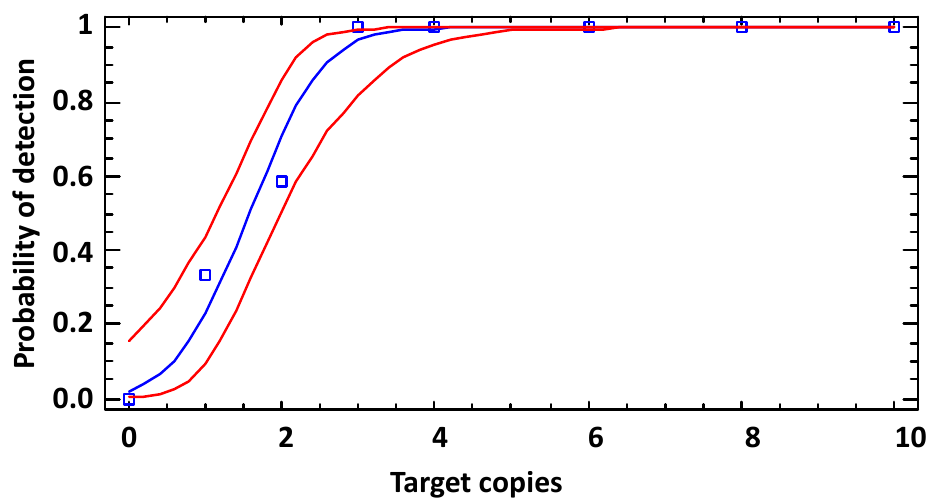
Figure 2. Limit of detection (LoD) of the 16S rRNA SNP-PCR (analytical sensitivity). DNA fragments comprising the 16S-BA-allele were diluted to the indicated copies per reaction (numerical data in Table S14) and subjected to real-time PCR (12 replicates for each data point). Probit analysis (plot of fitted model) was performed to determine the LoD by fitting template copies against the cumulative fractions of positive PCR observations (blue squares and line) and used for calculating the lower and upper 95% confidence limits (red lines).